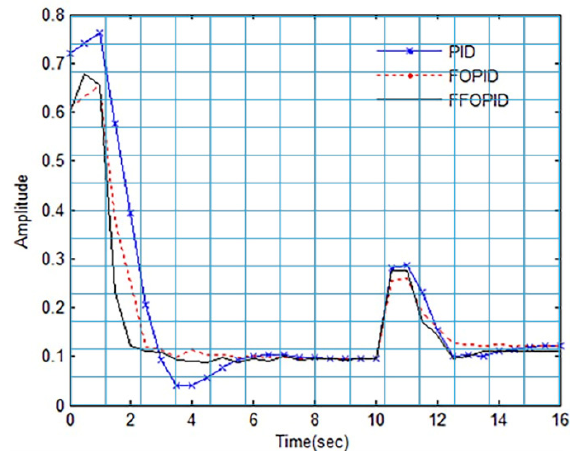
Figure 6. Response of load disturbance using different controllers.